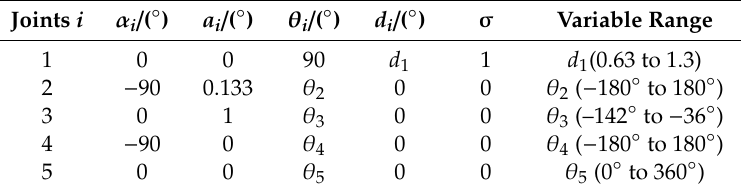
Table 1. Kinematic parameters of manipulators.